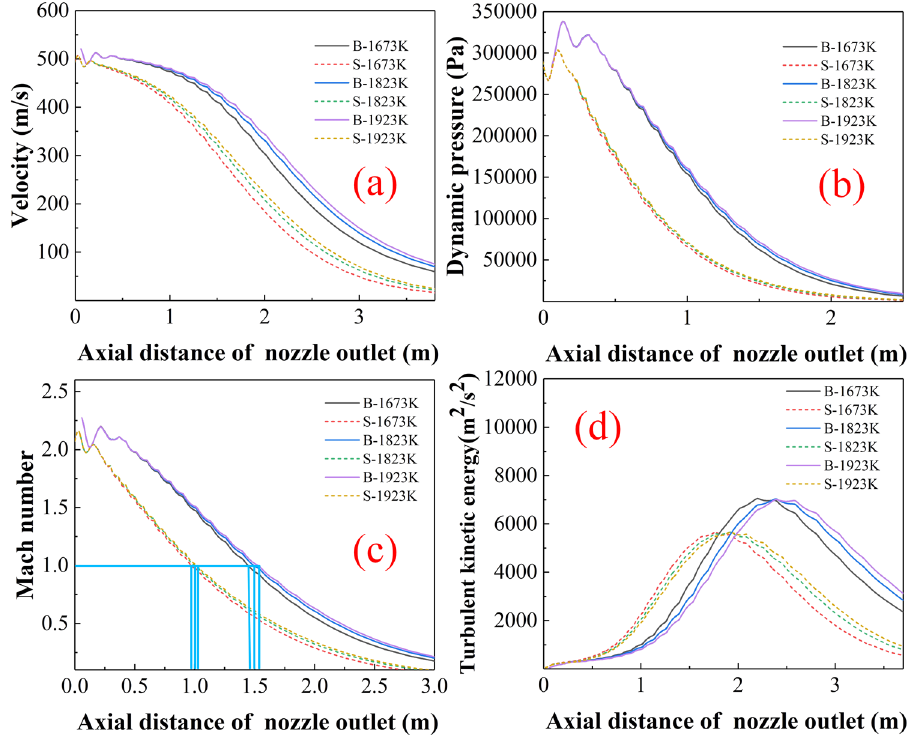
Figure 5: Jet characteristics of the nozzle axis at di ff erent ambient temperatures: ( a ) velocity, ( b ) dynamic pressure, ( c ) Mach number, and ( d ) turbulent kinetic